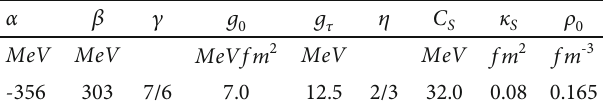
Table 1: The IQ2 parameters